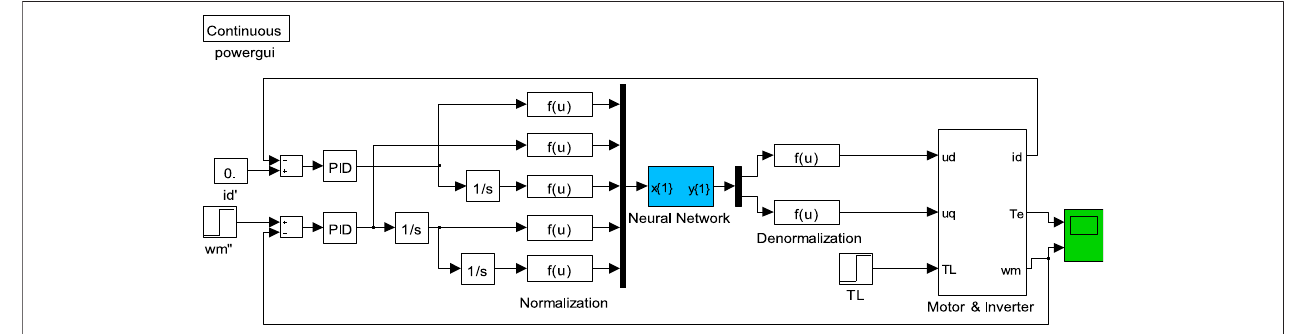
FIGURE 3 | NNIS of PMSM decoupling control system.